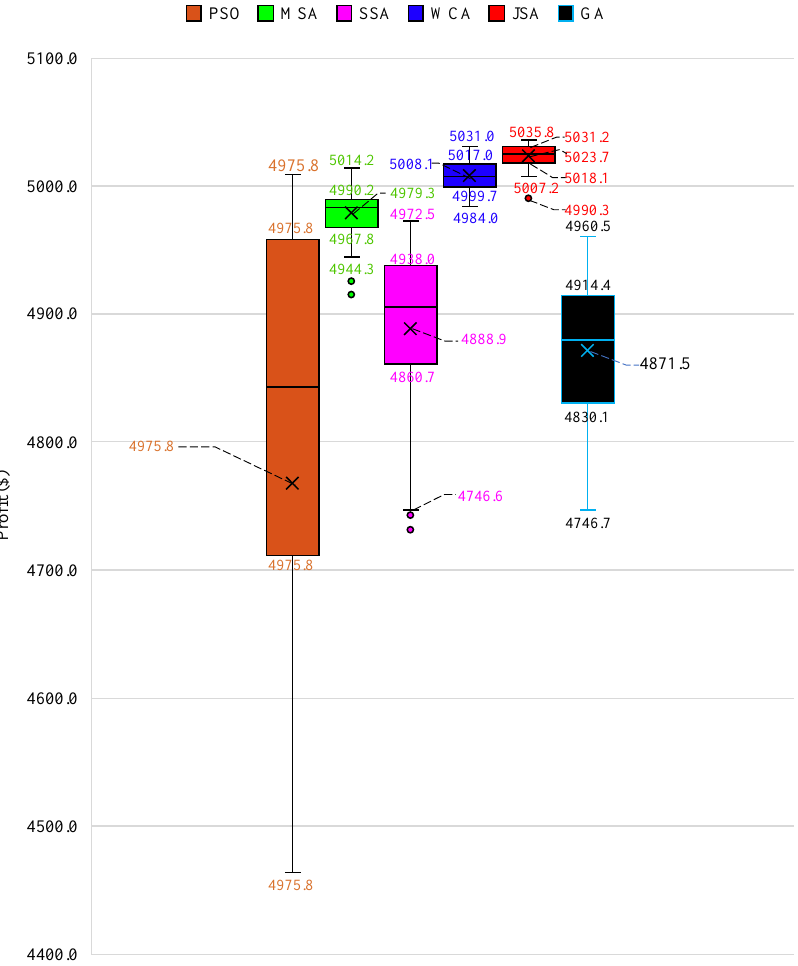
Figure 9. Summary of results obtained for Case 3.